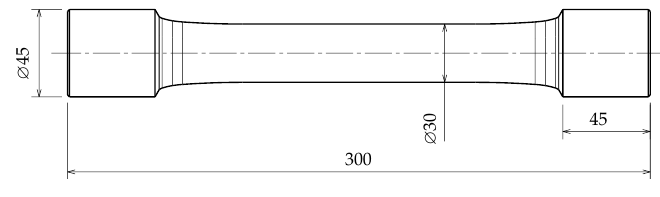
Figure 11. Final geometry of the large-scale